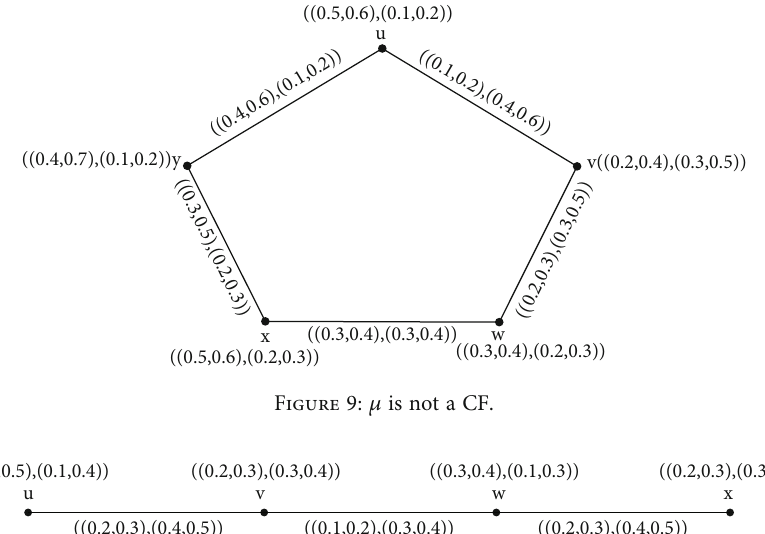
Figure 9: μ is not a CF.